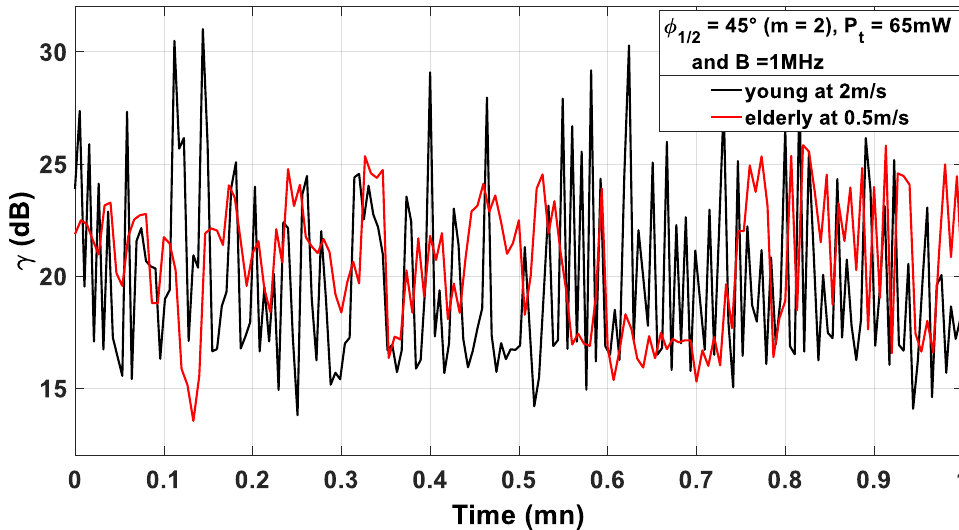
Figure 11. 𝛾 as a function of time for an example of RW trajectory during 1 min. Figure 11. γ as a function of time for an example of RW trajectory during 1